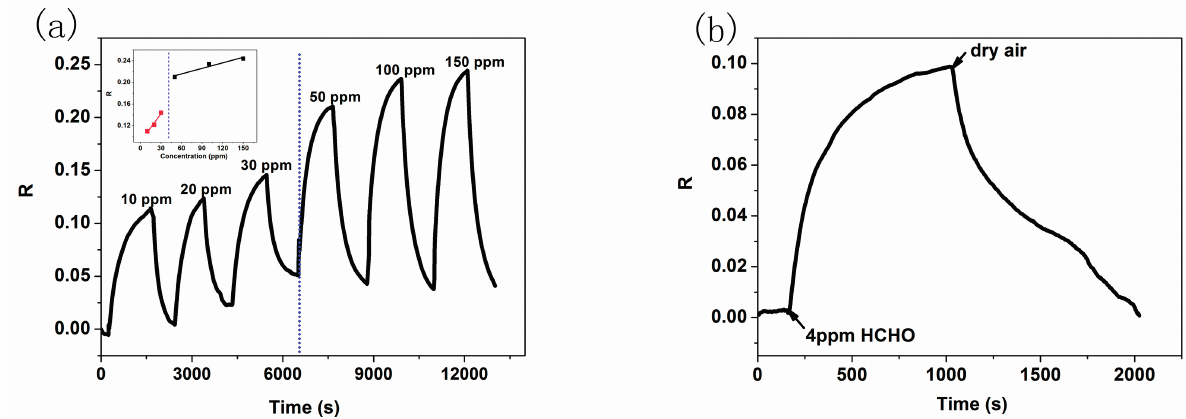
Figure 9. ( a ) The transient response of P3HT-ZnO hybrid film sensor when exposed to different HCHO concentrations, inset was the curve of response values versus concentration; ( b ) the detection limit (4 ppm) measurement curve at room